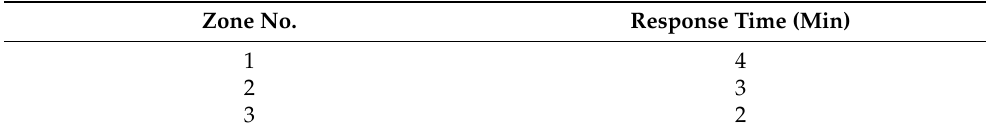
Table 4. Basic response time for various zones. Zone